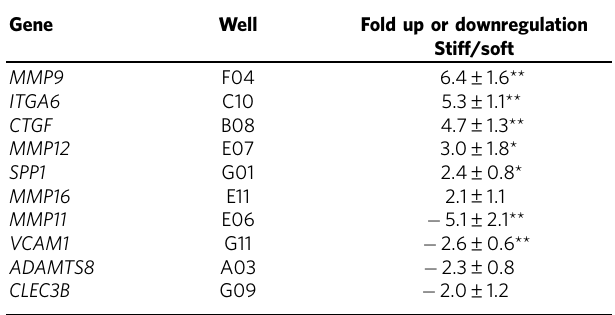
Table 1 | Matrix stiffness-regulated cell adhesion and